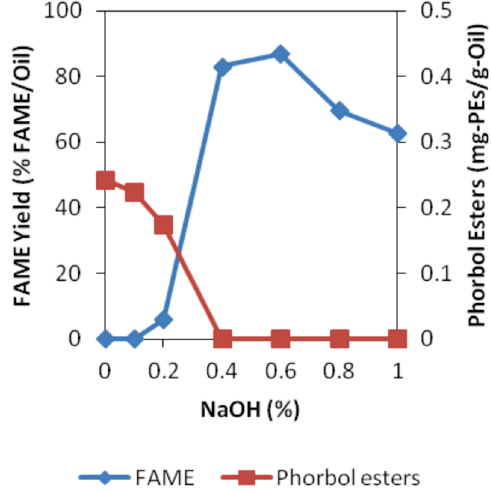
Fig. 1. Effect of NaOH on FAME yield and phorbol esters concentration in BDF after 2 h reaction in alkaline catalyzed transesteri fi